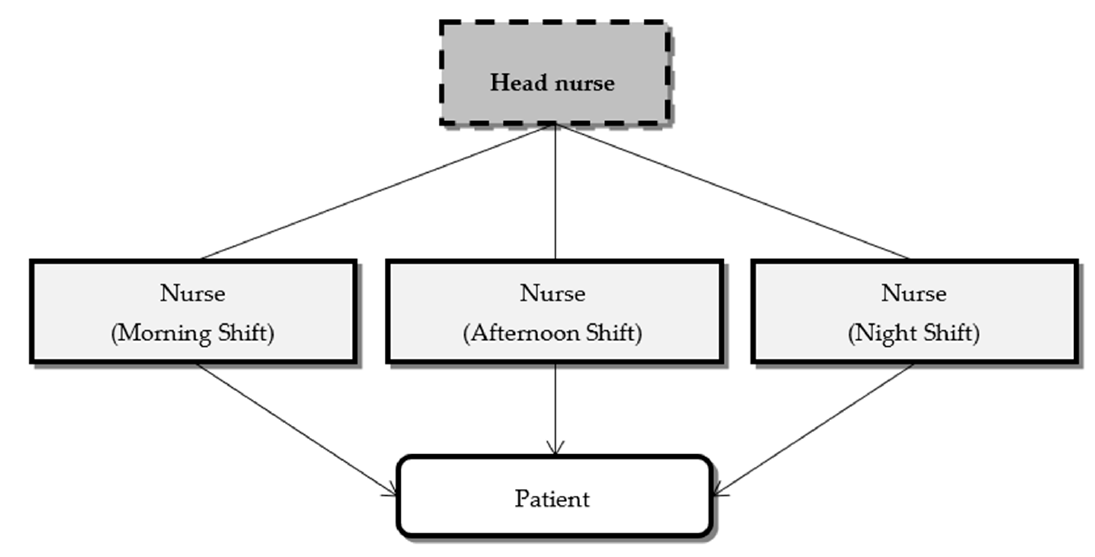
Figure 4. Structure of the individual method.